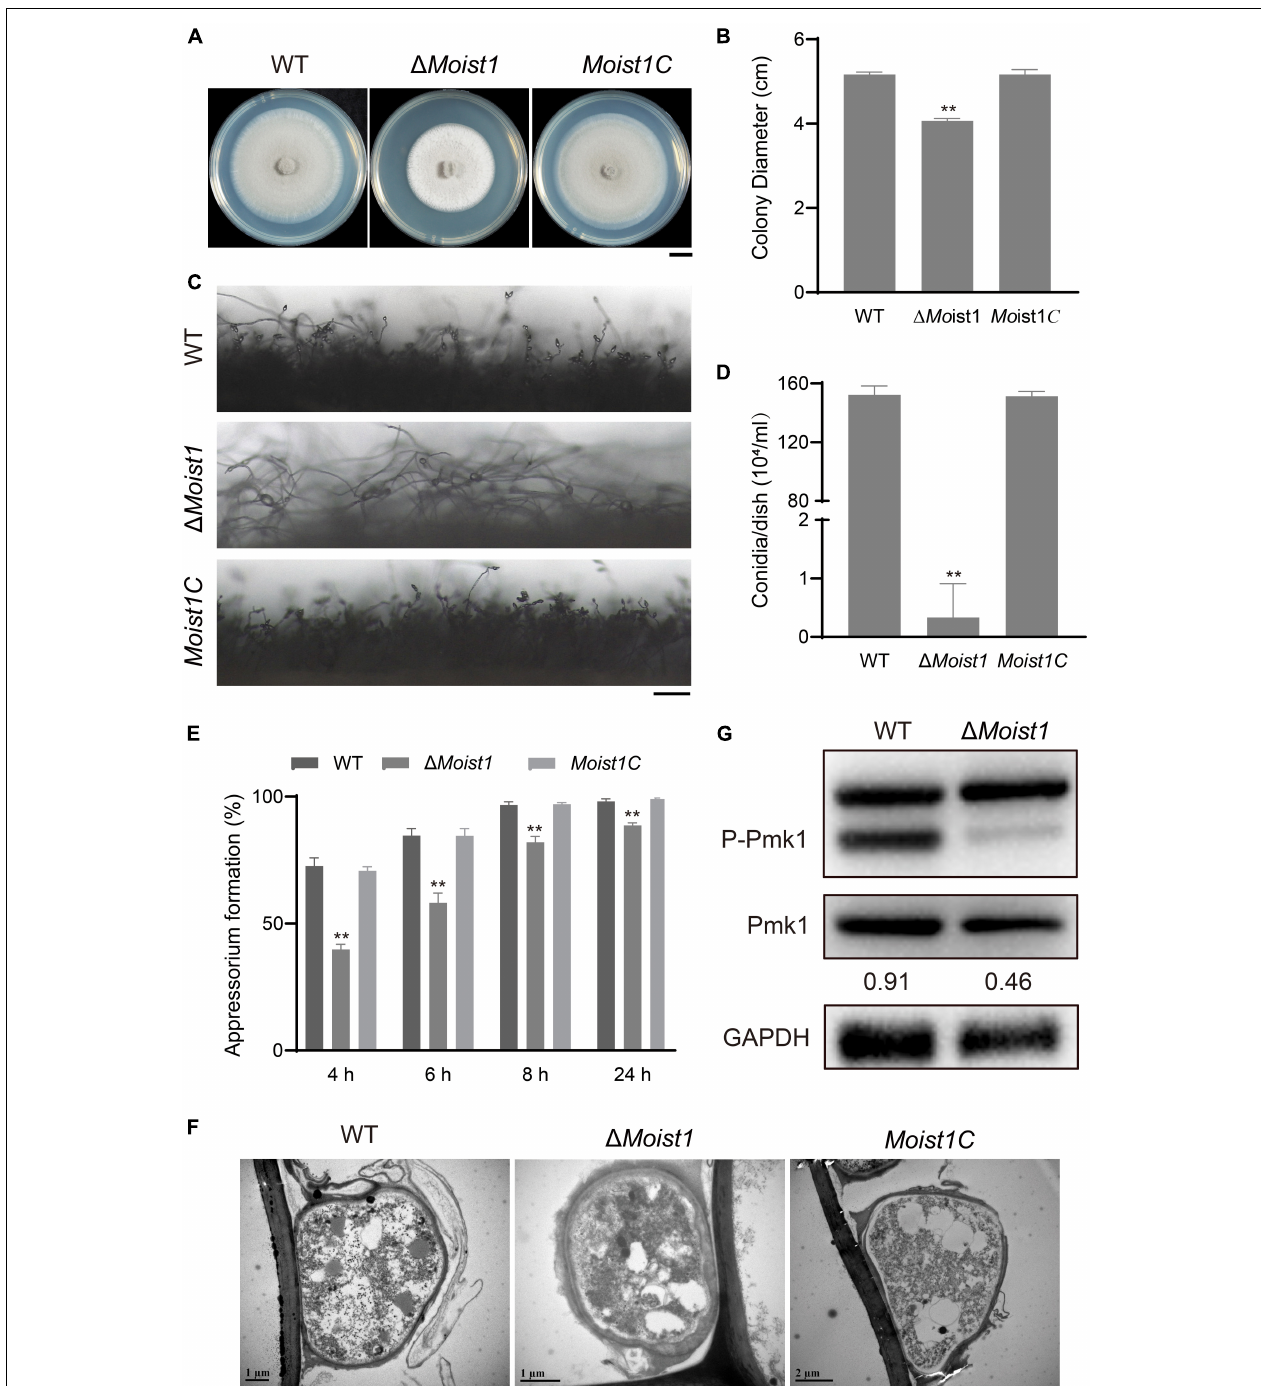
FIGURE 1 | MoIst1 is involved in sporulation and appressorium development in M. oryzae . (A) WT, (cid:49) Moist1 and Moist1C were cultured on CM plates for 8 days to observe colony morphology. Bar = 1 cm. (B) Colony diameters of WT, (cid:49) Moist1, and Moist1C . The standard deviation is represented by error bars. Tukey’s test was used to test significant differences: ** P < 0.01. (C) Conidiophores of WT, (cid:49) Moist1, and Moist1C . Bar = 100 µ m. (D) Conidiation of WT, (cid:49) Moist1 and Moist1C . The standard deviation is represented by error bars. Tukey’s test was used to test significant differences: ** P < 0.01. (E) Appressorium formation rates of WT, (cid:49) Moist1, and Moist1C on hydrophobic surfaces. The standard deviation is represented by error bars. Tukey’s test was used to test significant differences: ** P < 0.01. (F) Appressoria of WT, (cid:49) Moist1 , and Moist1C were observed by transmission electron microscopy (TEM). (G) Non-phosphorylated and phosphorylated Pmk1 levels were detected by anti-ERK1/ERK2 MAPK and anti-phospho-p44/42 MAPK antibodies, respectively. GAPDH was used as an internal reference for protein standardization by Western blot.